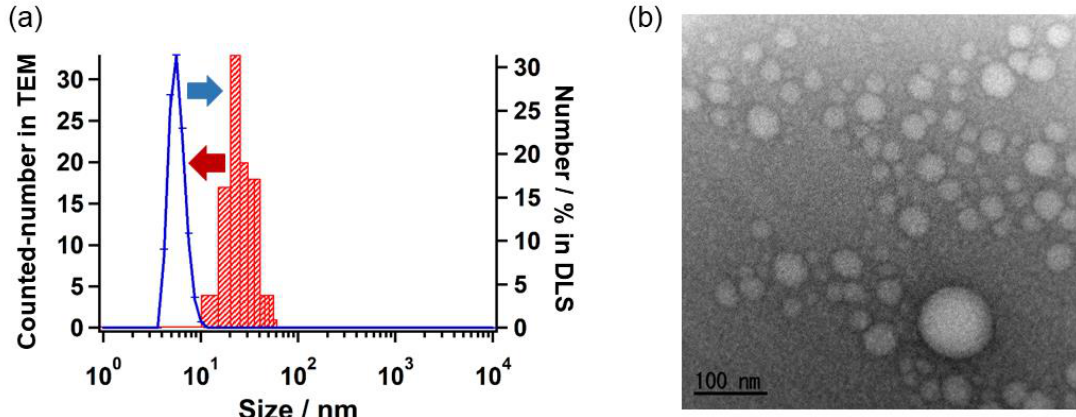
Figure 1. Sizes and morphologies of the particles. ( a ) Plots of the number of nanoparticles in the 5.0 mM TFMAQ-diEg4 solution, obtained using DLS as a function of the D H value (right axis; represented as a line graph), and those obtained using TEM as a function of size (left axis; represented as a histogram). ( b ) A representative TEM imaging of the TFMAQ-diEg4 solution (5.0 mM); the scale bar indicates 100 nm.